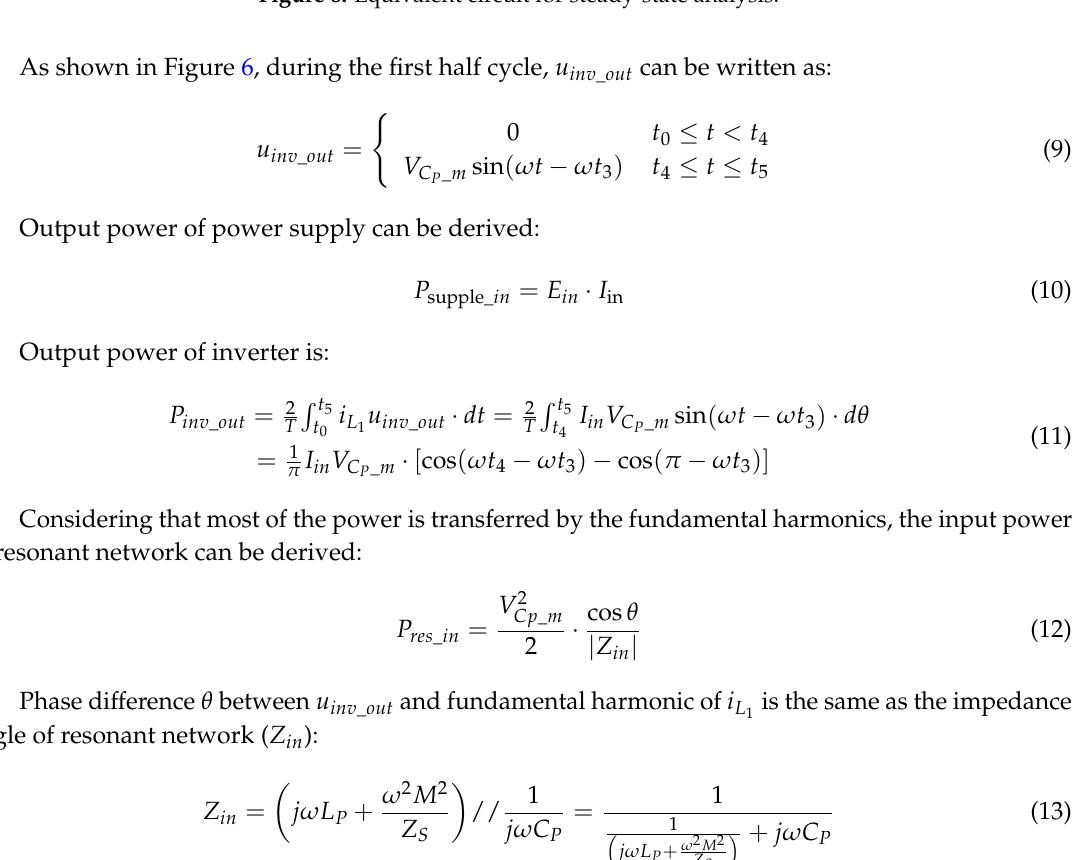
Figure 8. Equivalent circuit for steady-state analysis.